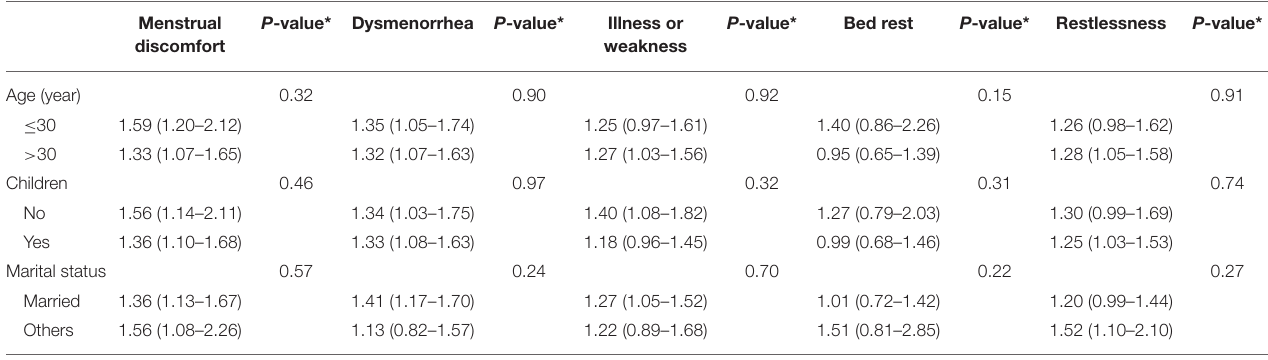
TABLE 4 | Subgroup analysis and interaction